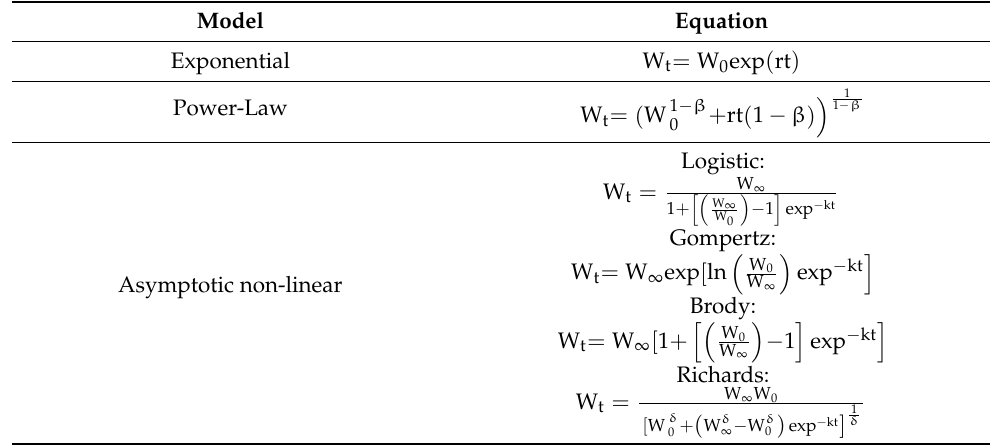
Table 2. The equations, parameters, and definitions of growth models